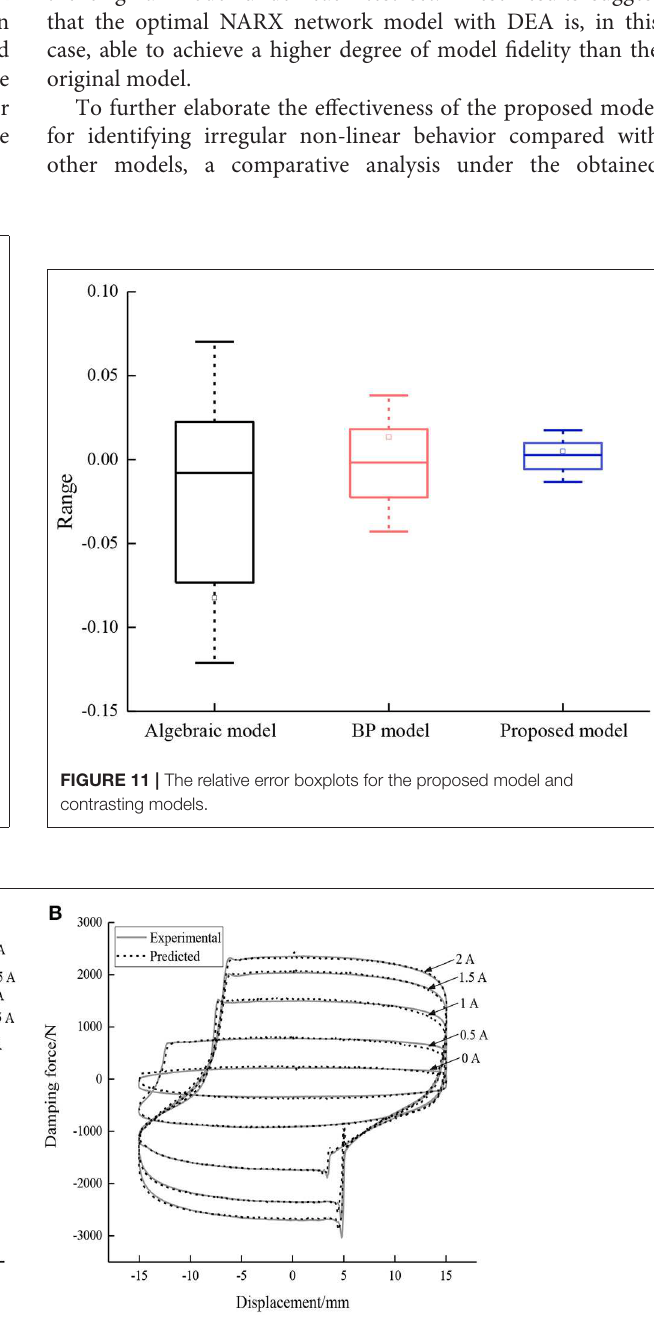
Frontiers in Materials |